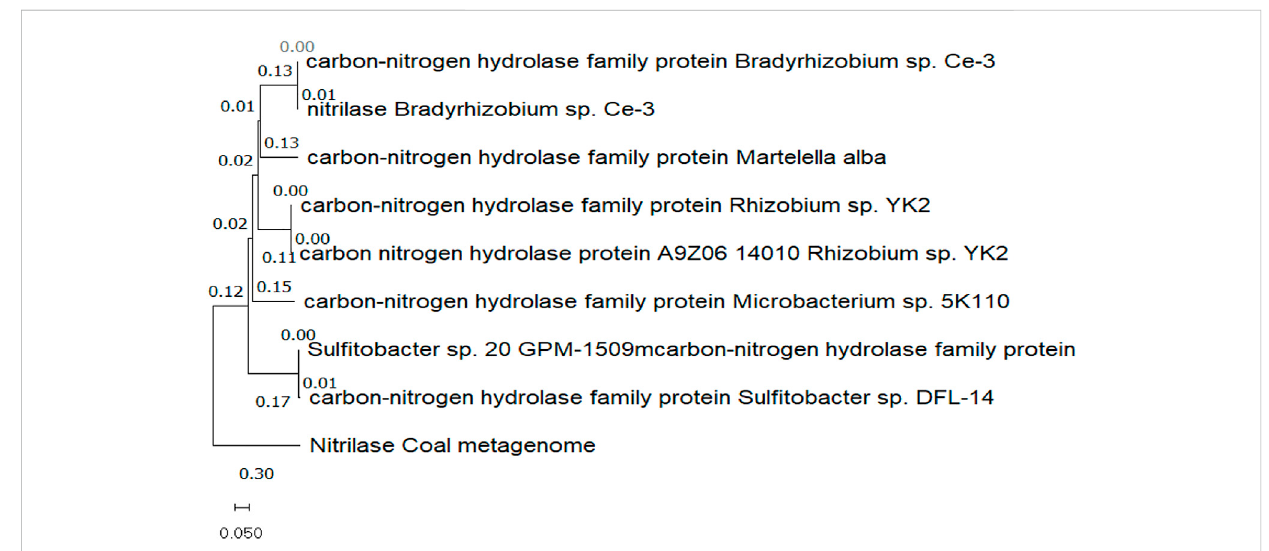
FIGURE 3 Phylogenetic tree showing the evolutionary relationship between nitrilase from the coal metagenome and other eight selected protein sequences from the NCBI database.